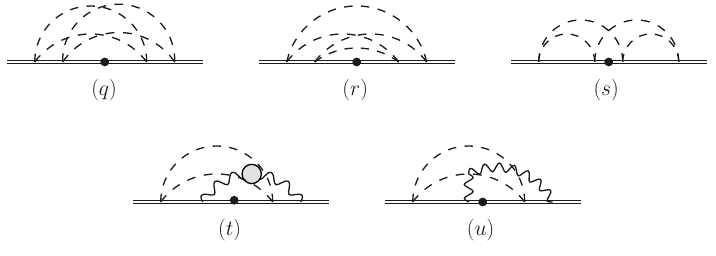
Figure 2 . List of non-planar diagrams contributing to the four-loop θ -Bremsstrahlung function.